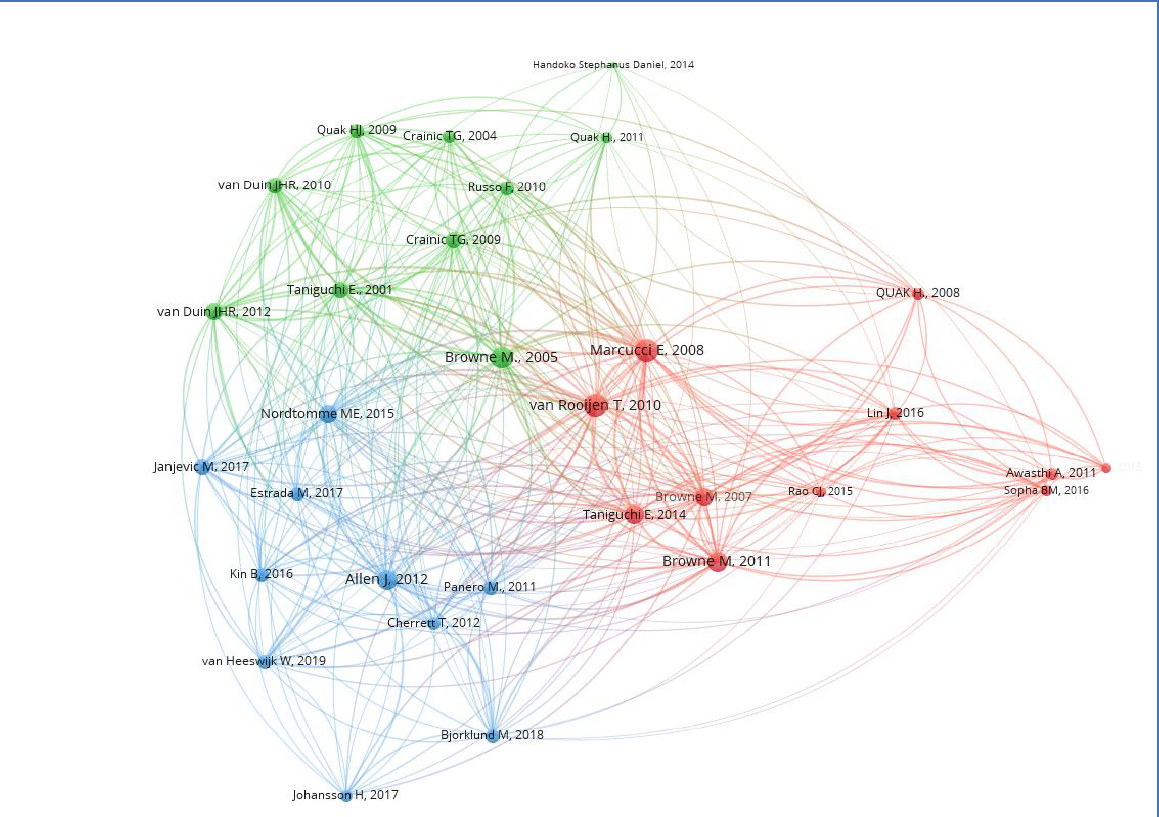
Figure 3. Network analysis of the co-occurrence of highly cited authors. Cluster A (red-colored network) in Figure 3 mainly focuses on UDCs. It underlines research by renowned authors who have written multiple articles and co-occurred